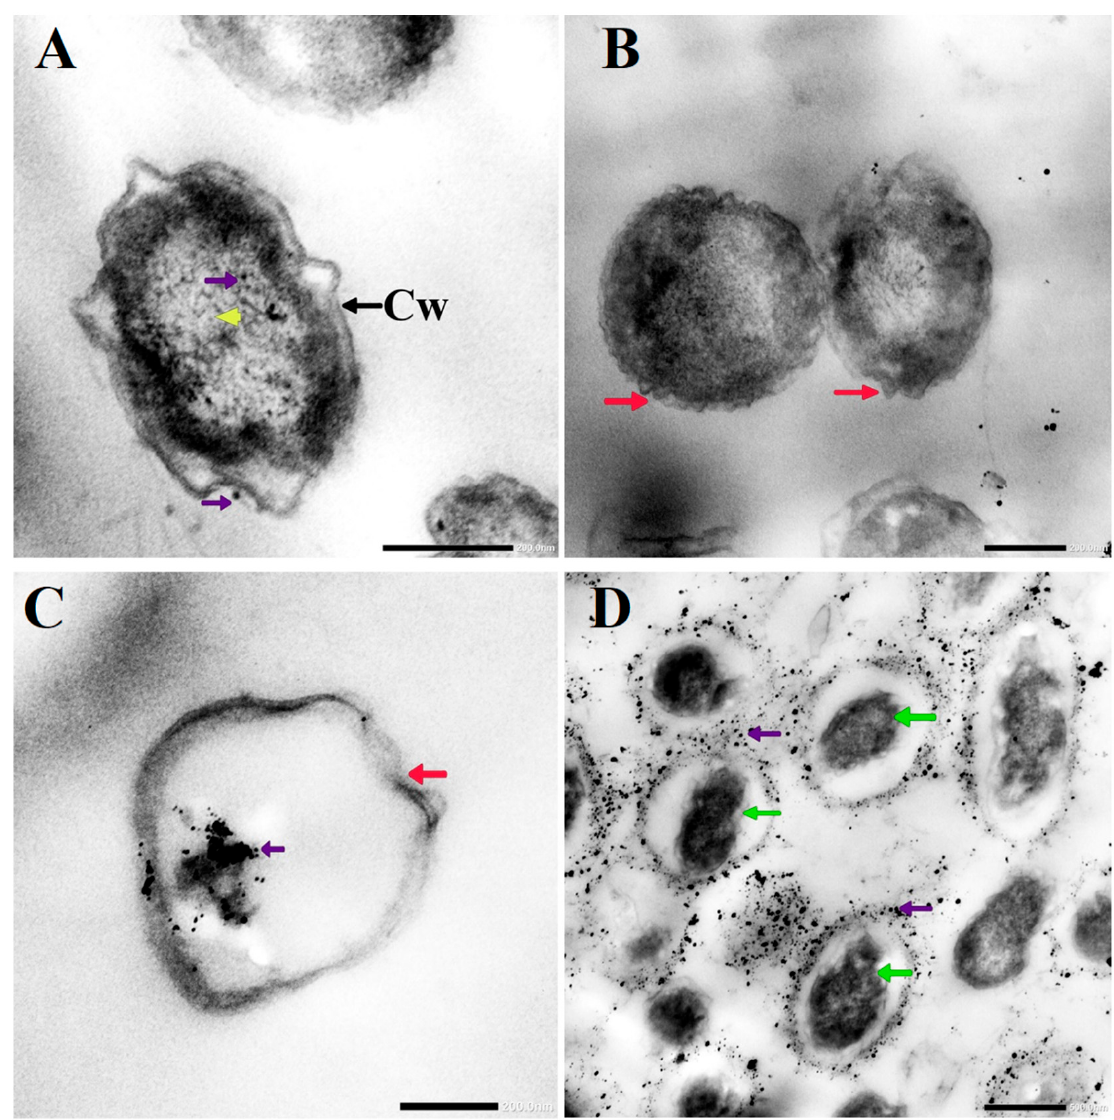
Figure 6. TEM micrographs of Candida albicans exposed to D-SNPs ( A , B ) and N-SNPs ( C , D ) showing the irregular cell wall (Cw), folded membrane (red arrow), cytoplasmic lashing (yellow arrowhead), nucleoagglutination (green arrow), and NP distribution inside and outside the cells (violet arrow).